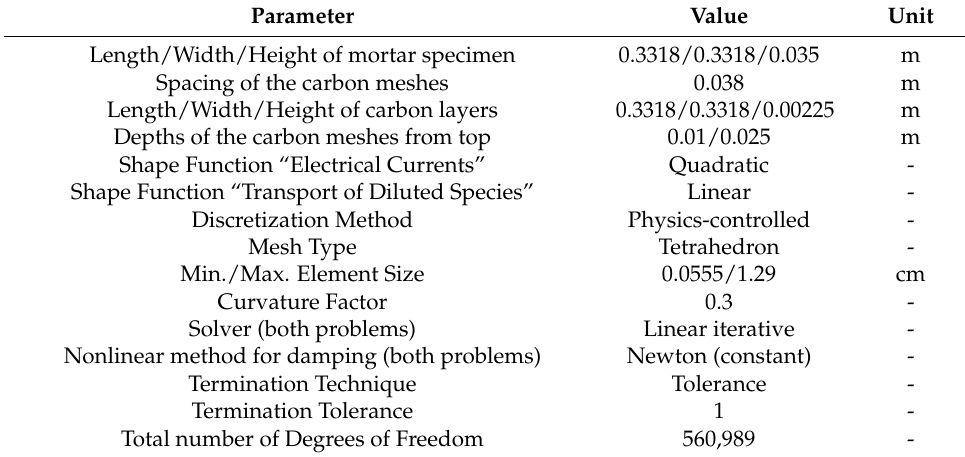
Table 1. Parameter values used in COMSOL for the multi-physics